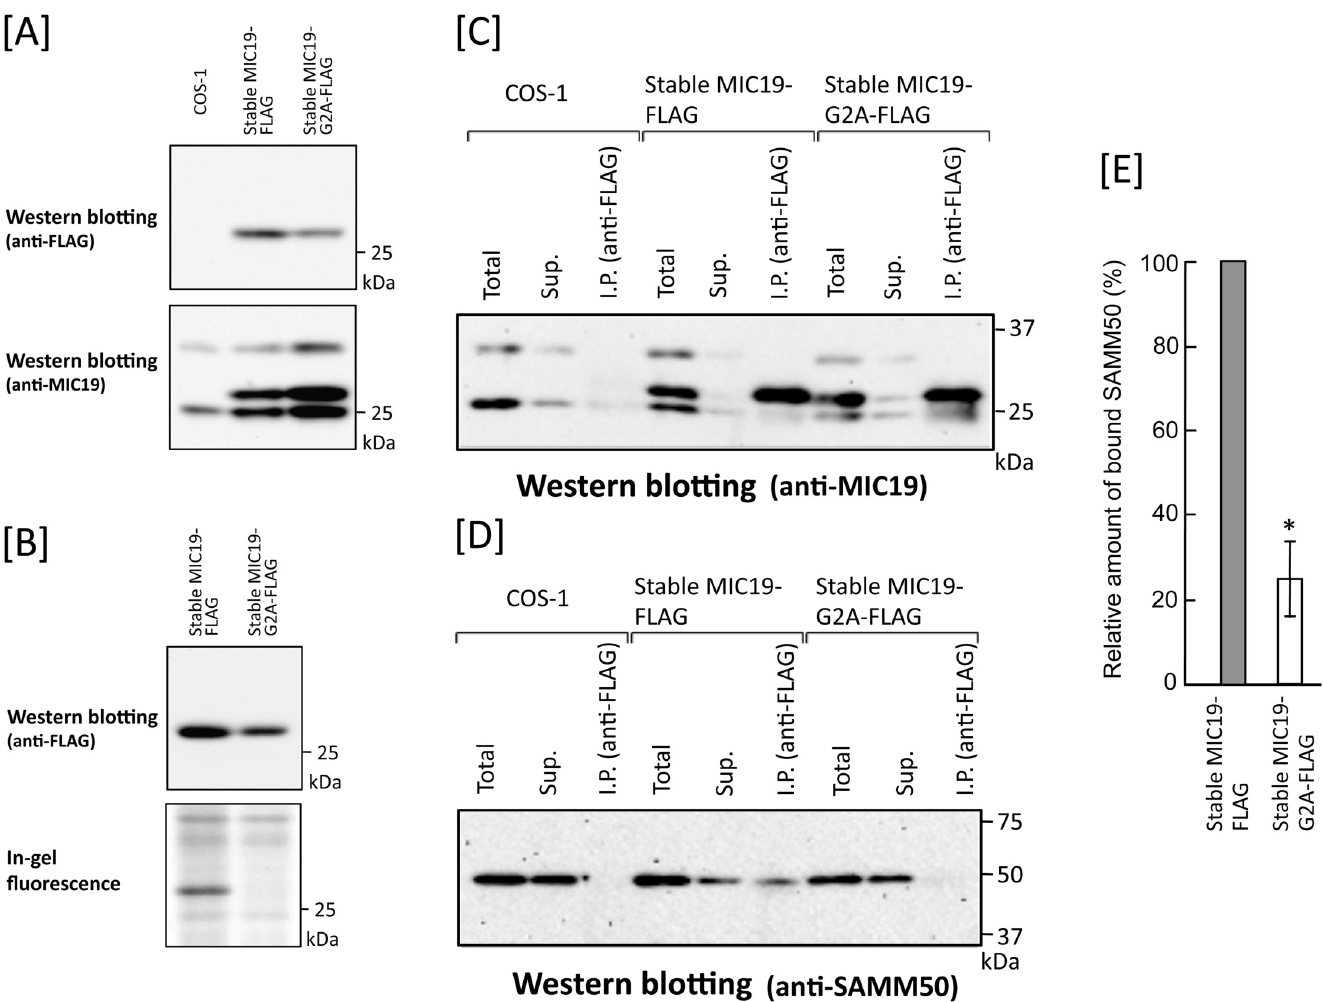
Fig 11. Protein N -myristoylation of MIC19 is required for the association of MIC19 with SAMM50. Association of MIC19-FLAG stably expressed in COS-1 cells with endogenously expressed SAMM50 was studied by immunoprecipitation analysis. A. Expression of MIC19-FLAG and MIC19-G2A-FLAG in respective stable transformants. Upper panel; Western blotting analysis using an anti-FLAG antibody, Lower panel; Western blotting analysis using an anti-MIC19 antibody. B. Detection of protein N -myristoylation of MIC19-FLAG expressed in stable transformants of MIC19-FLAG. Upper panel; Western blotting analysis using an anti- FLAG antibody. Lower panel; Detection of protein N -myristoylation by metabolic labeling with myristic acid analog followed by detection with click chemistry. C. Western blotting analysis of MIC19-FLAG or MIC19-G2A-FLAG immunoprecipitated from stable transformants of MIC19-FLAG and MIC19-G2A-FLAG using an anti-MIC19 antibody. D. Analysis of the binding of MIC19-FLAG or MIC19-G2A-FLAG to endogenous SAMM50 by western blotting analysis of immunoprecipitated samples of stable transformants of MIC19-FLAG and MIC19-G2A-FLAG using an anti-SAMM50 antibody. The experiments were performed in triplicate. A typical pattern of western blotting is presented. E. Quantitative analysis of MIC19-FLAG or MIC19-G2A-FLAG bound to SAMM50 was performed using the results obtained in D. Data are expressed as mean ± SD for three independent experiments. � P < 0.01 vs. wild-type.